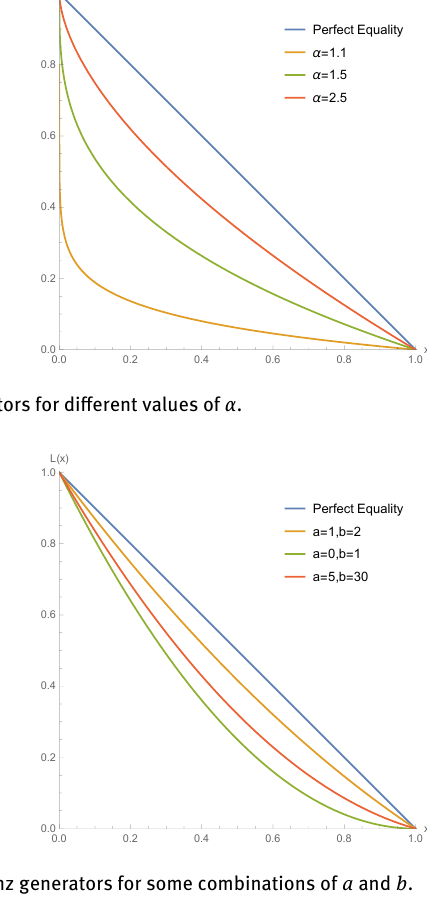
Figure 10: Examples of uniform Lorenz generators for some combinations of a and b .